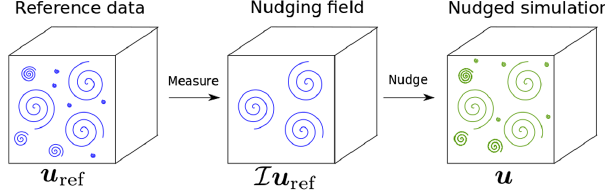
FIG. 1. Diagram outlining the nudging algorithm. In our numerical experiments the reference data come from a well- controlled direct numerical simulation, and the process of measuring is summarized by the filtering operation I